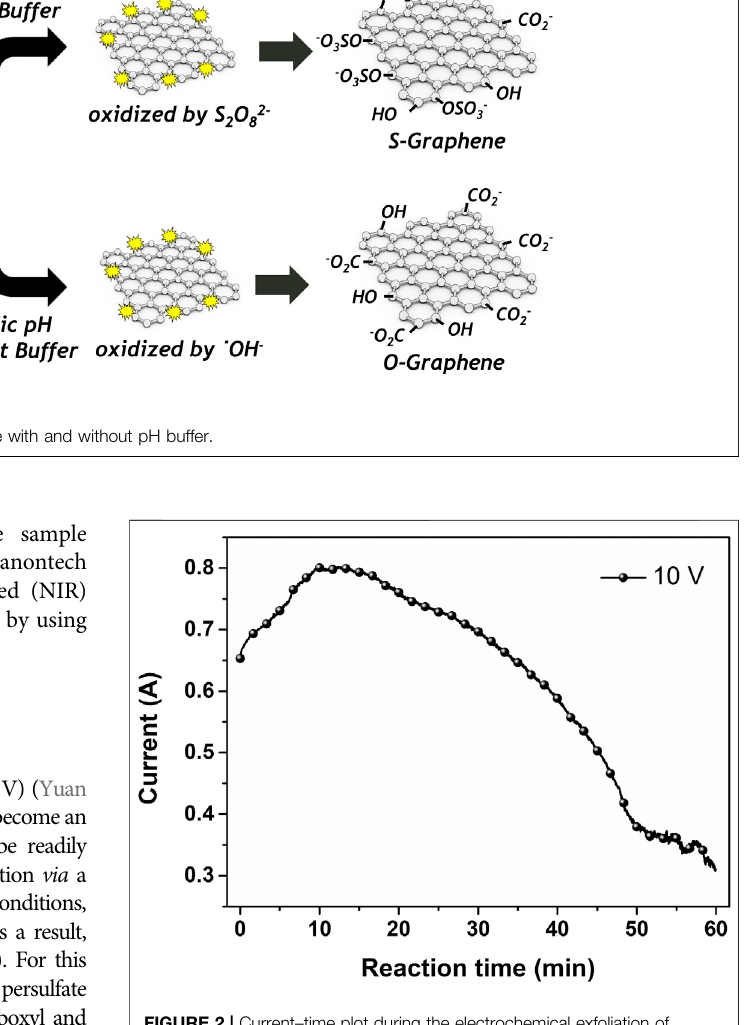
FIGURE 2 | Current – time plot during the electrochemical exfoliation of graphite applying 10